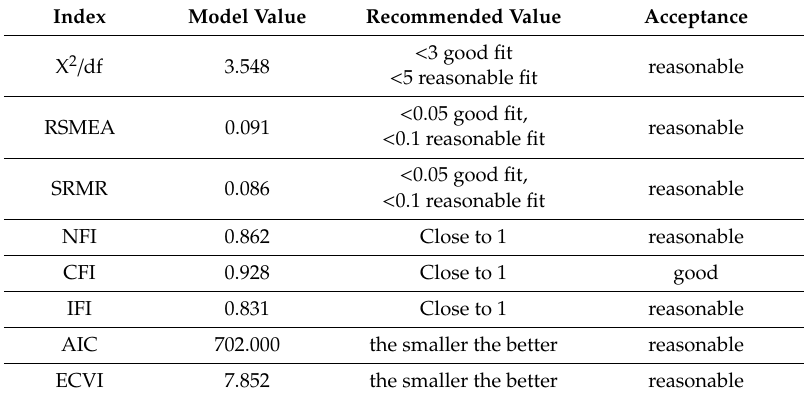
Table 4. Model fitting